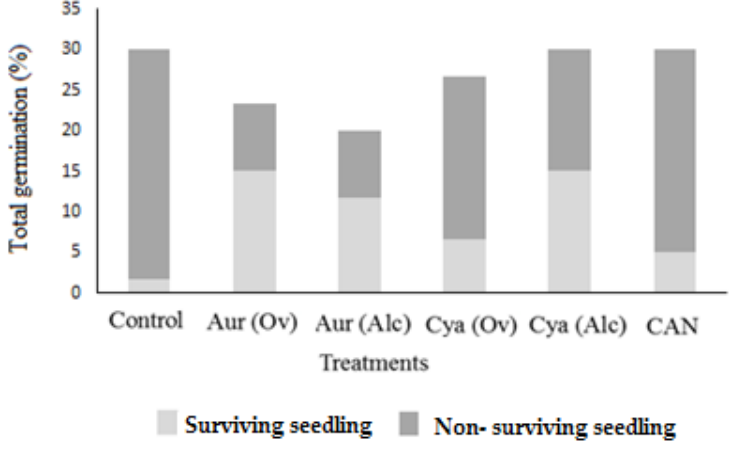
Figure 3. Total germination for final seedling emergence (including surviving and non-surviving seedlings) for each of the different treatments.